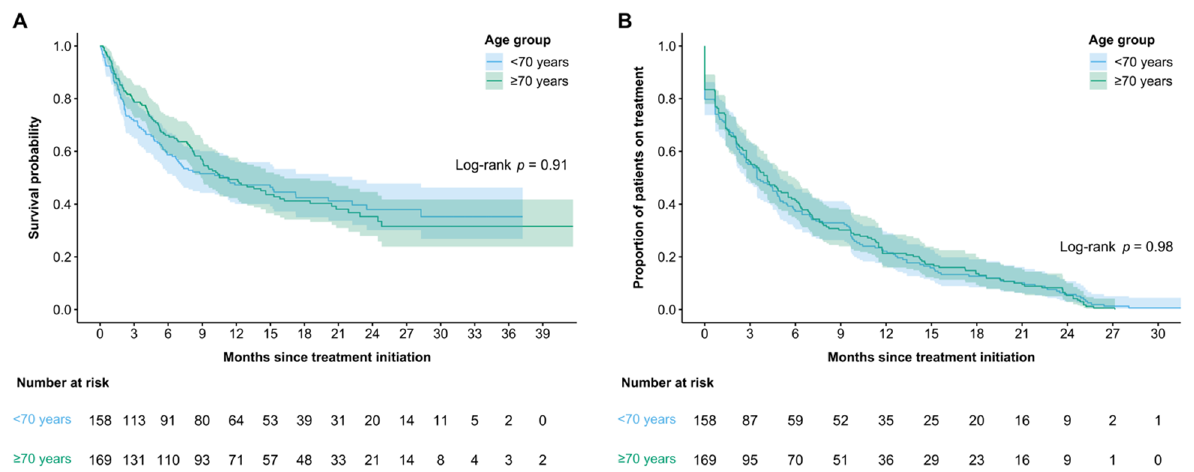
Figure 1. Kaplan − Meier curves for median: ( A ) overall survival (OS) and ( B ) time to treatment failure (TTF) by age.